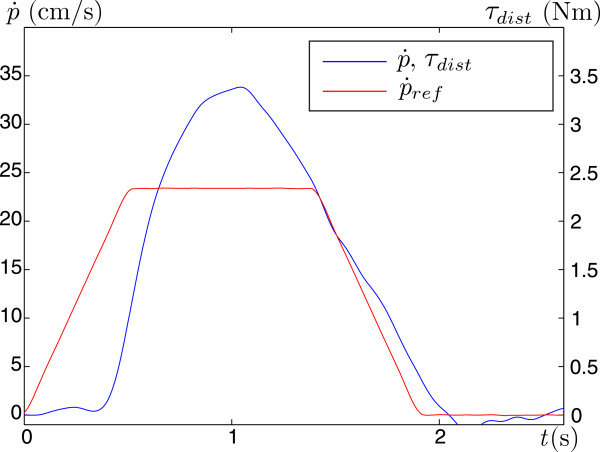
Velocity of the handlebarp˙, reference velocityp˙ref, and disturbance torque τdist. The predefined reference velocity (trapezoidal velocity profile) is in every trial the same. The translational velocity also corresponds to the disturbance torque (Equation 2).